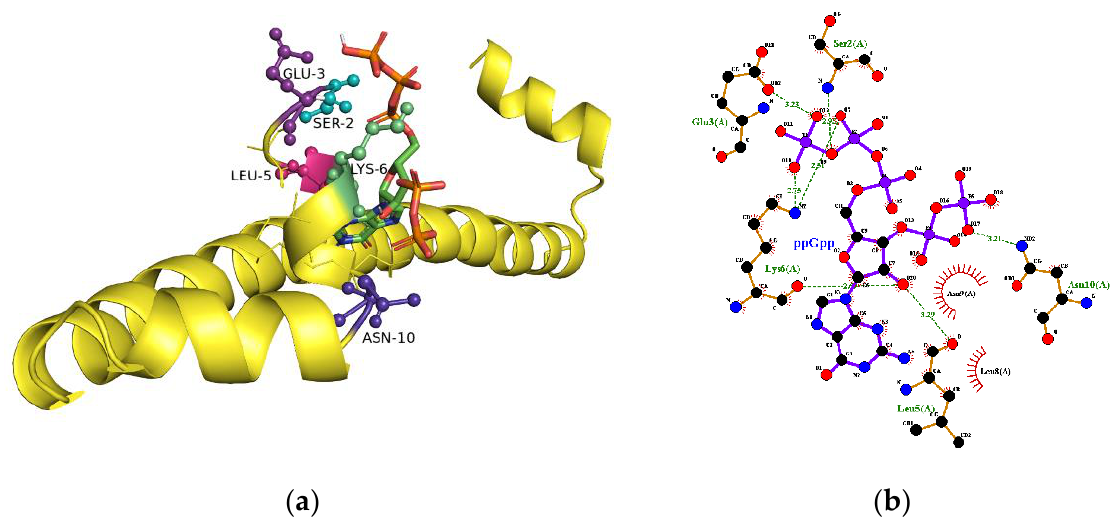
Figure 4. Interaction of ppGpp with N-NS. ( a ) The ppGpp binding site proposed by a molecular modeling study. The interactions between ppGpp and H-NS are shown as dotted lines. ( b ) Interacting residues at the binding site. S2, E3, K6, and N10 interact with phosphate groups of ppGpp.